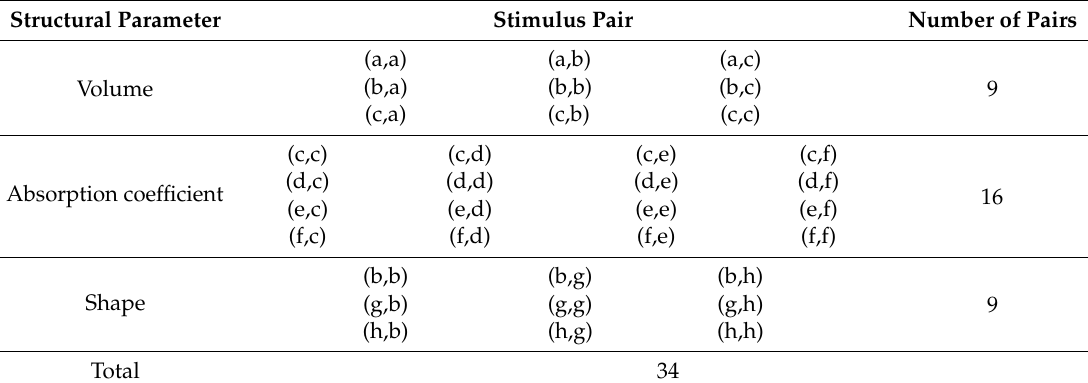
Table 7. Stimulus pairs of a musical sound at the same receiving